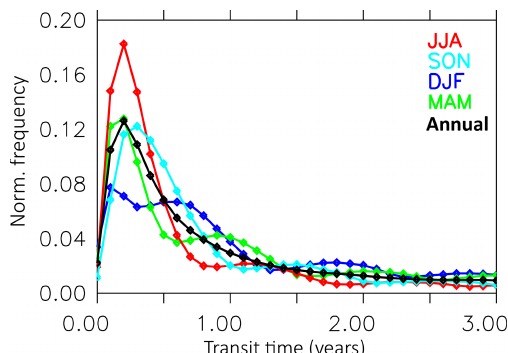
Figure 9. Zonal mean difference of AoA (LG(diab)–GP) from the SF 6 _AoAc tracer (with a spatially constant surface source of SF 6 ). The non-stippled area is statistically significant to the 99% level.